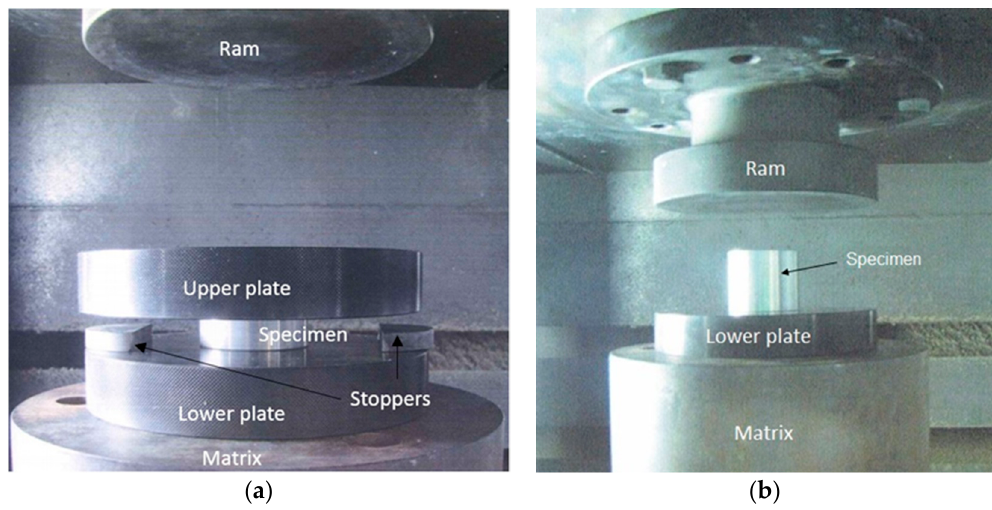
Figure 1. Experimental setup of: ( a ) a ring upsetting test, ( b ) a cylindrical specimen upsetting test. The upper pressing plate is not shown in this setup.